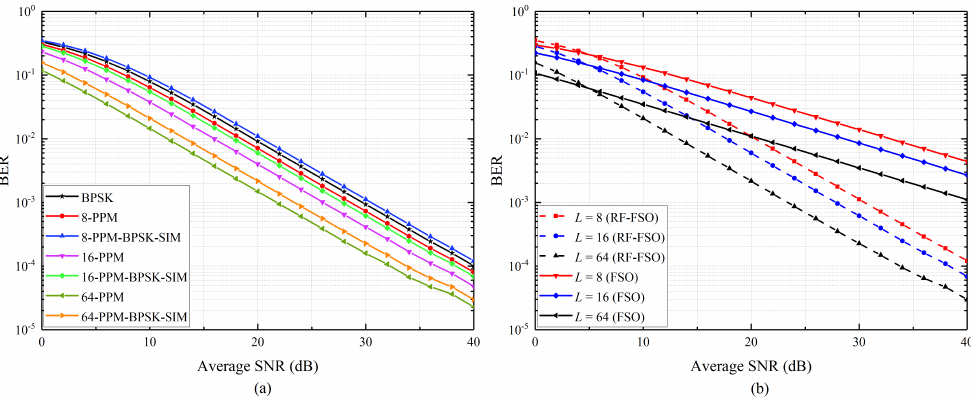
Figure 8. When m 2 = 0.3, i.e., under weak scintillation ( a ) average BER of BPSK, L -PPM and L -PPM– BPSK–SIM against average SNR; ( b ) average BER of L -PPM–BPSK–SIM with various L on the hybrid RF/FSO system and FSO system against the average